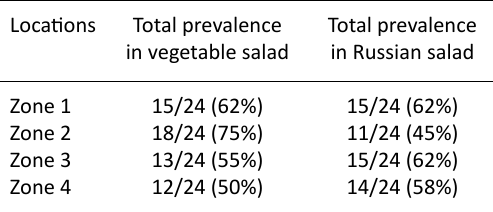
Table 2. Prevalence of Listeria in salad samples from